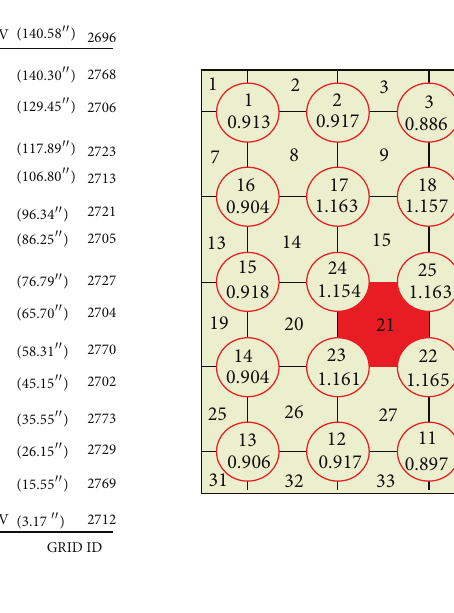
Figure 7: A case example of a 5 × 5 bundle